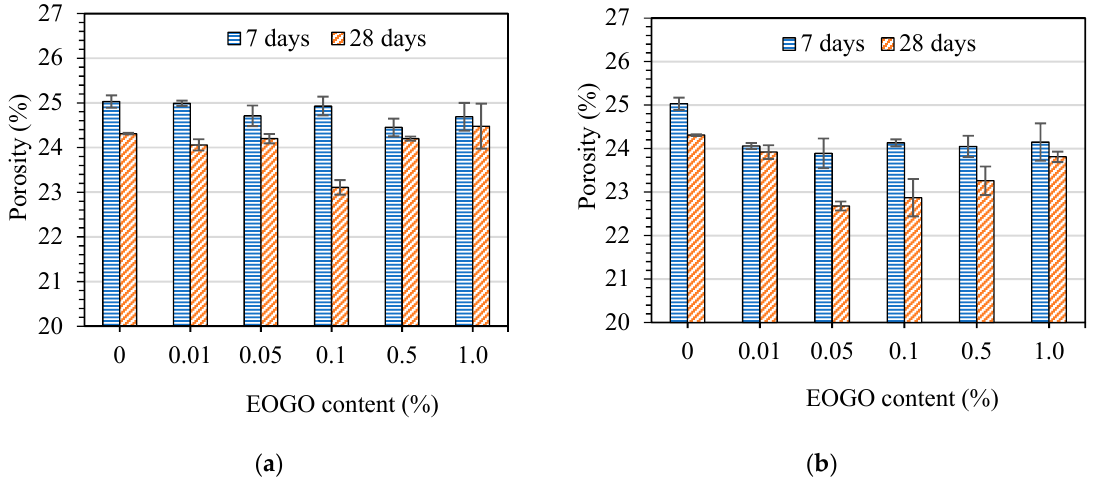
Figure 11. Effect of EOGO on the porosity of cement pastes: ( a ) Dry-mix design and ( b ) wet-mix design.